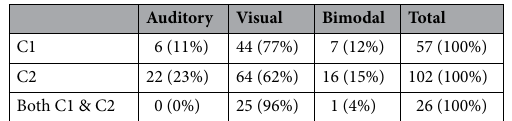
Table 1. Cue modality sensitivity of C1- and C2-responsive